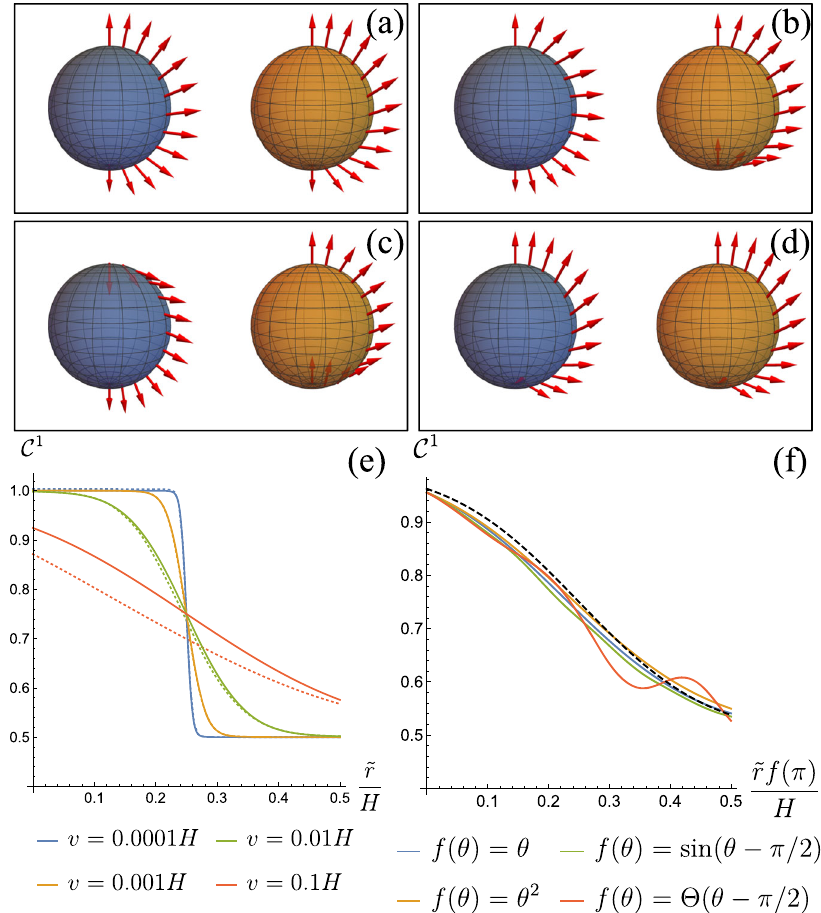
Fig. 3 Time evolution for interacting spin-1/2s. a – d Spin responses 〈 σ 1 〉 (on the blue sphere) and 〈 σ 2 〉 (on the orange sphere) to a sweep protocol of the radial applied magnetic fi eld along a meridian of the sphere with sweep velocity v = 0.0001 H . The time-dependent spin vectors shown in red are determined from the numerical solution of the Schrödinger equation. The radius of each sphere is the magnetic fi eld strength H . a – c An asymmetric case where the bias fi elds for the two qubits are M 1 = H /3 and M 2 = H /2. The Ising couplings between the qubits are given by ( a ) ~ r ¼ 0 : 25 H . b ~ r ¼ 0 : 9 H . c) ~ r ¼ 1 : 7 H . d – f show the symmetric case with M = M = 3 H /4. d Spin response for ~ r ¼ H = 3. In this case, the magnitude of the spin vector vanishes at the 1 2 south pole. e Chern number of a single spin versus the normalized coupling ~ r = H for different sweep velocities v (shown in different colors) with interaction coef fi cient f ( θ ) = 1. The solid lines show the analytic approximation of Eq. (24), while the dotted lines show the result from the numerical solution to the Schrödinger equation. f Numerically determined Chern number of a single spin vs ~ rf ð π Þ = H shown by the solid lines for different interactions with v = 0.05 H ; Θ refers to the Heaviside step function. The dashed black line shows the analytic approximation of Eq. (24) which is universal for a given speed v